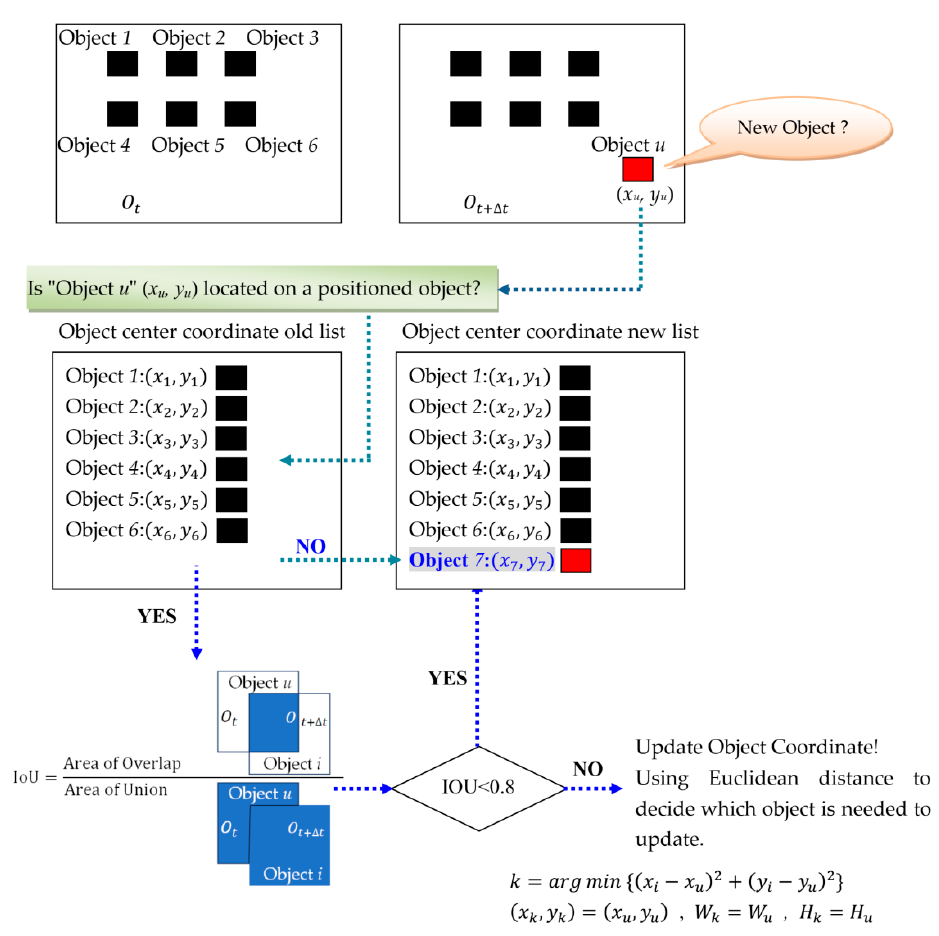
Figure 6. The flowchart of the positioning correction.